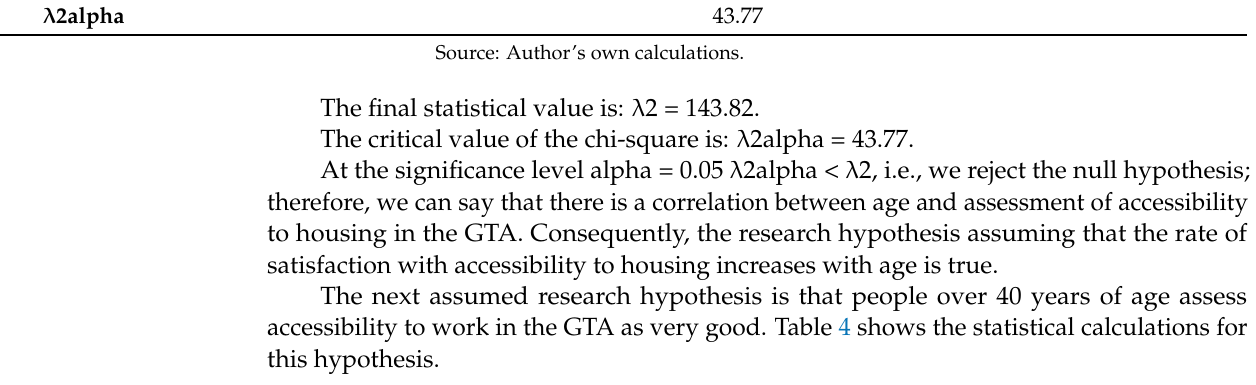
Table 4. Age and accessibility to